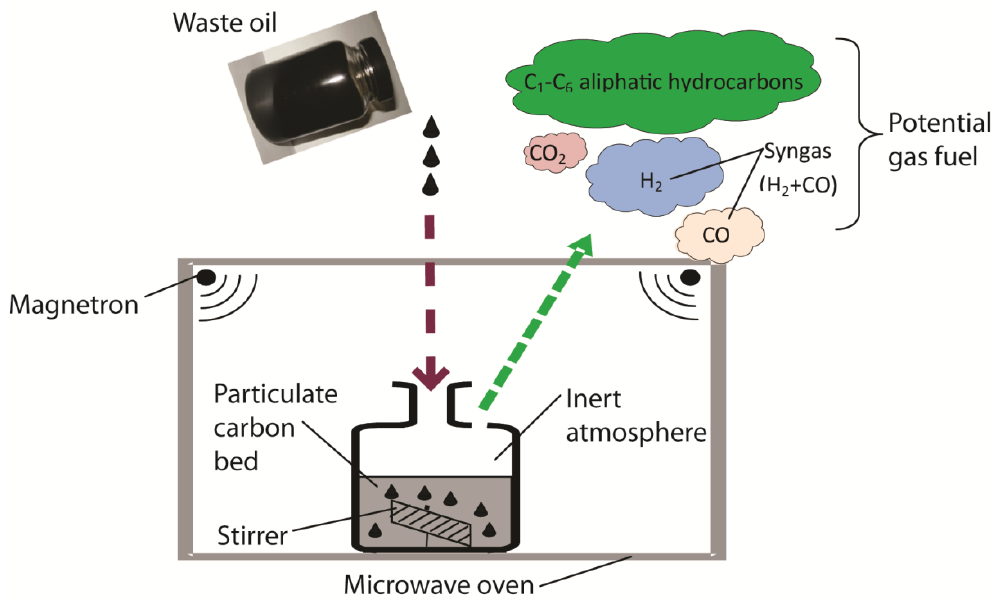
Figure 4. Schematic representation of the generation of light aliphatic hydrocarbons and syngas from microwave pyrolysis of waste oil